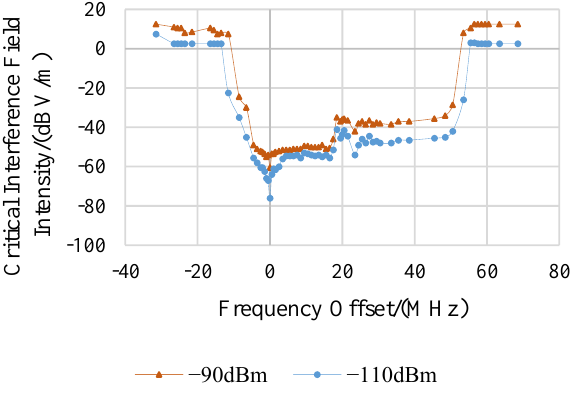
Figure 4. Sensitivity curves of − 90 dBm and − 110 dBm working power.